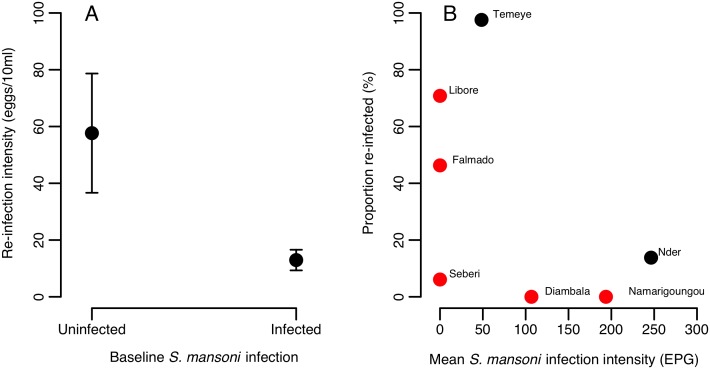
Relationship between S. haematobium re-infection 6 months post-PZQ in Senegalese and Nigerien villages, and S. mansoni co-infection at the point of treatment (baseline).(A) Negative association between S. mansoni co-infection and the intensity of S. haematobium re-infection from a negative binomial GLM on Senegalese data (n = 70). Values are predicted values from the minimal model in Table 6A, for an individual of average age, living in Temeye with a light S. haematobium infection prior to treatment. Errors bars represent 1 standard error. (B) Relationship between mean S. mansoni infection intensity and the proportion of individuals re-infected with S. haematobium six months after PZQ treatment across seven villages in Niger (red dots) and Senegal (black dots).